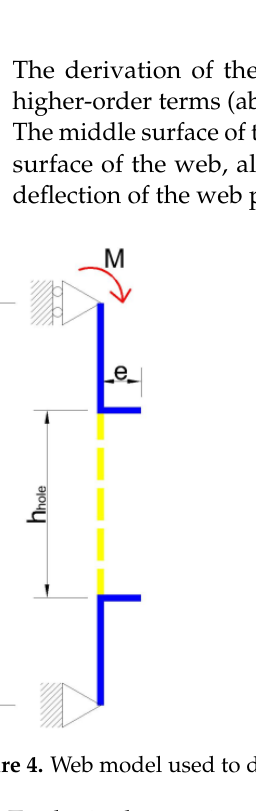
where C is a constant that represents the rotational angle of the upper flange–web edge about the x -axis; h is the web depth; notice that the deflection assumed above satisfies the boundary conditions of the web model (see Figure 4).